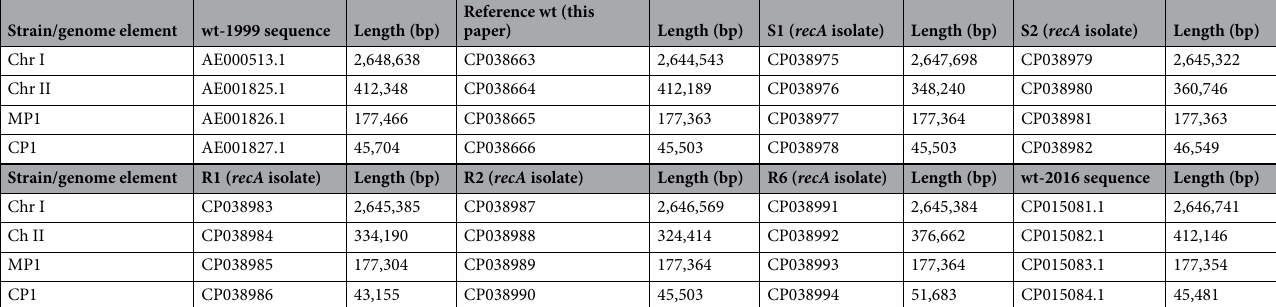
Table 1. GenBank accession numbers and sizes of contigs assembled by Canu for reference wild type (wt) and recA isolates, in comparison to the previously sequenced D. radiodurans wt genomes described by White et